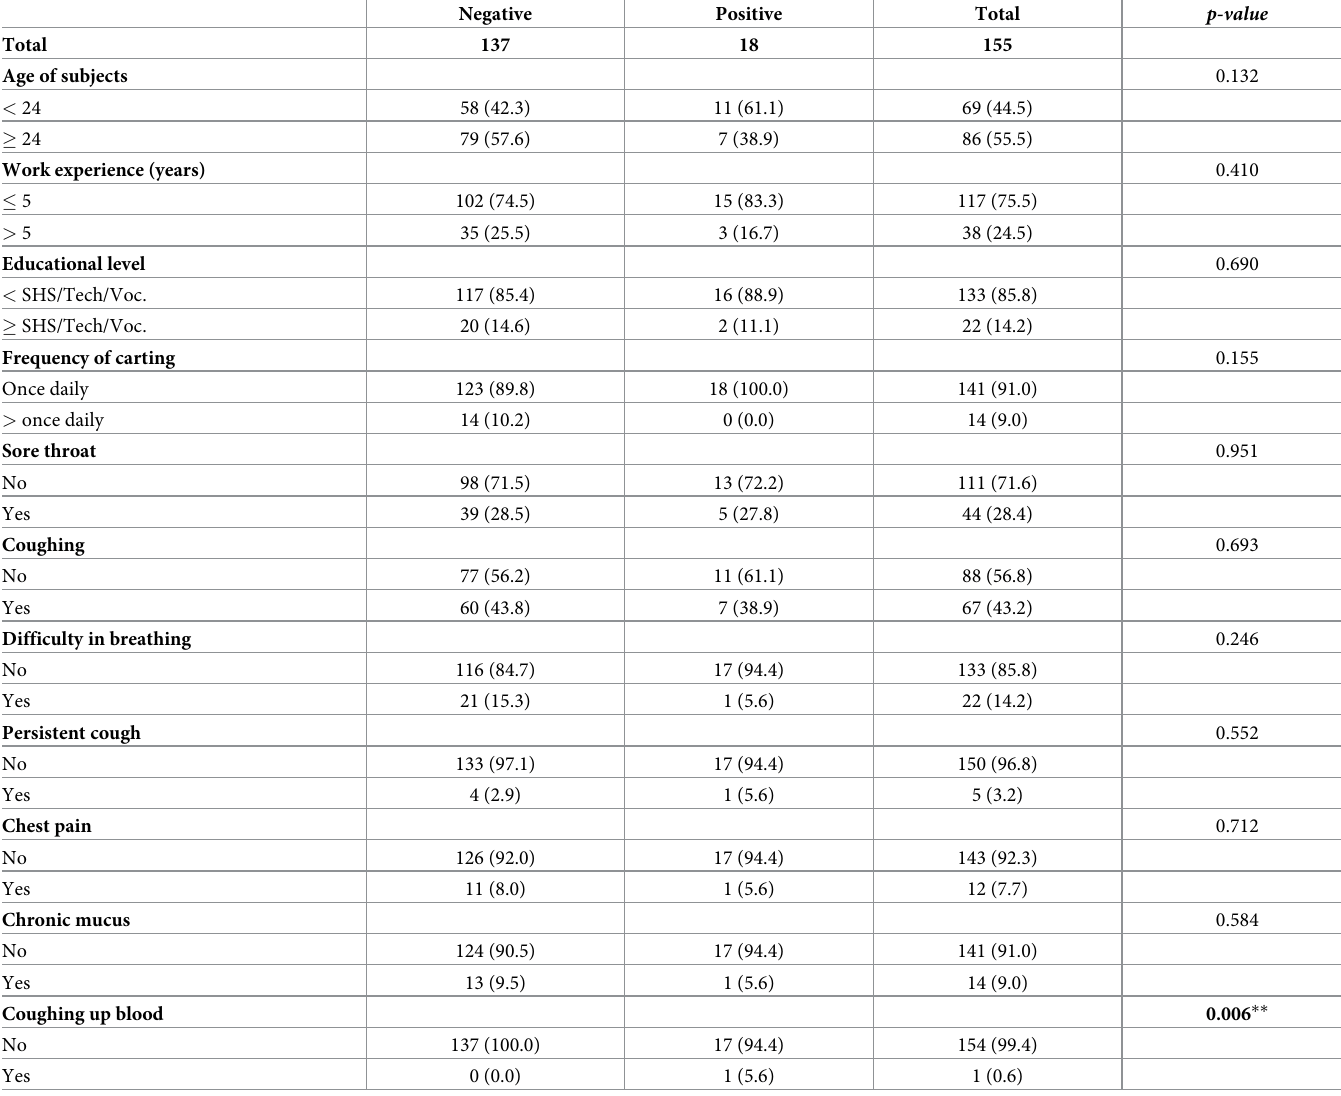
Table 2. Socio-demographic and clinical characteristics of